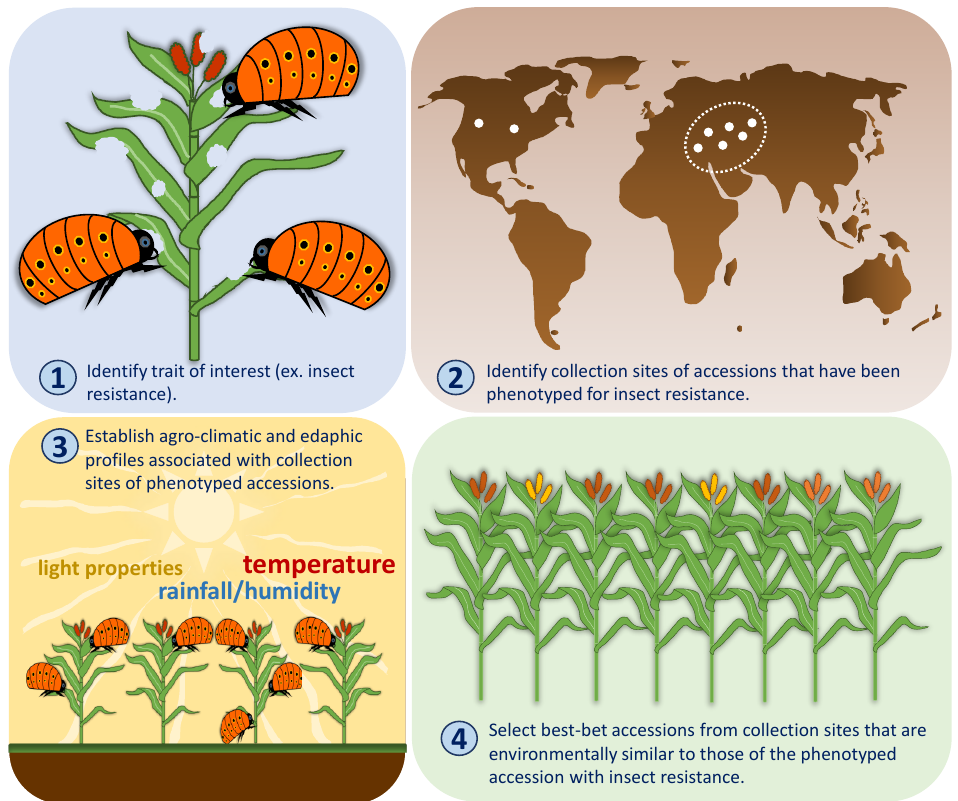
Select best-bet accessions from collection sites that are environmentally similar to those of the phenotyped accession with insect resistance. Figure 2 Figure 2. Using limited phenotype data for a FIGS search. In the presence of evaluation data for a limited number of accessions, the eco-geographical profile of the sites where the phenotyped accessions were collected can be used as a basis to identify other accessions that are most likely to possess the target